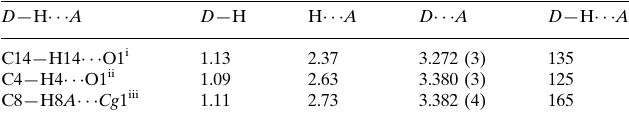
Hydrogen-bond geometry (A˚ , (cid:2) ). Cg 1 is the centroid of the C11–C16